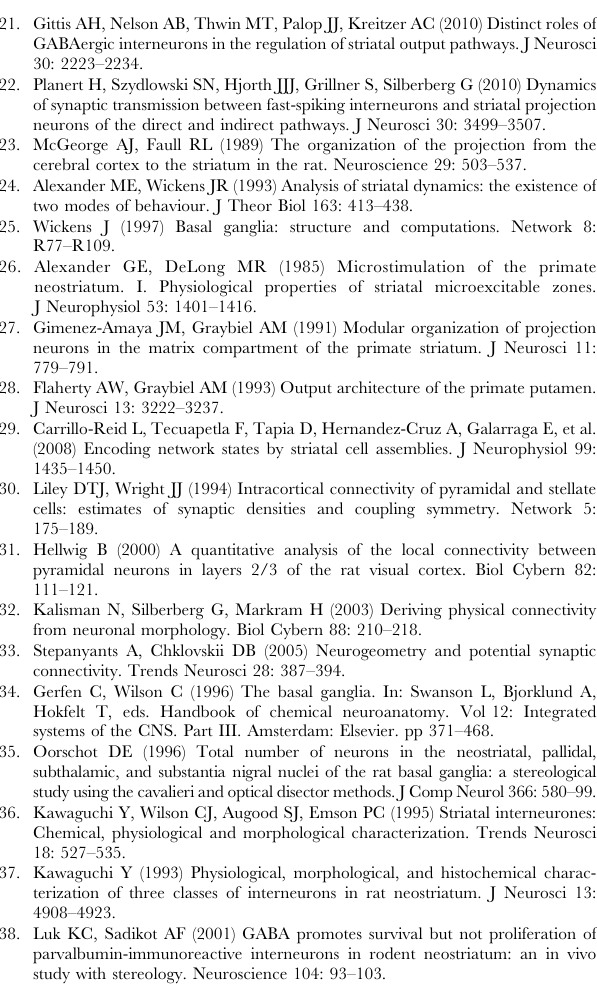
Figure S1 Implications of distance-dependent connections for MSN output. We stimulated all neurons within a 50 m m wide spherical shell at varying distances from the centre of a 1mm-on- the-side cube of striatum (84900 MSNs). Here we used a network with a FSI density of 3% (2547 FSIs) to check that the effects on the centre MSN were consistent even with increasing numbers of FSIs. A. The total number of neurons per shell increases exponentially with increasing distance from the centre; here and in all other panels we plot distances as the inner radius of the shell. B. The probability of any chosen neuron in that shell contacting the central MSN falls exponentially with increasing distance.